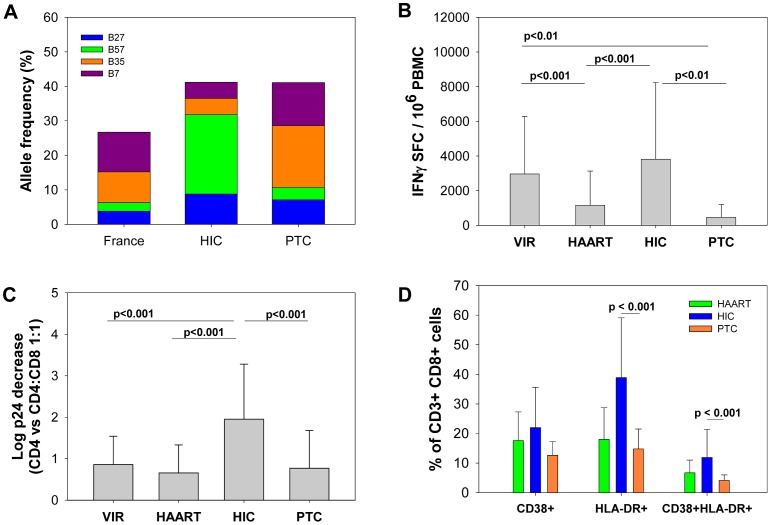
Post-treatment controllers differ from HIV controllers in terms of HLA class I profile, frequency and quality of the CD8+ T cell response and activation levels of CD8+ T cells.
A. The frequencies of the protective alleles HLA-B*27 and B*57 and the risk alleles HLA-B*07 and B*35 in the general French population (n = 6094 alleles [20], www.allelefrequencies.net), HICs (n = 148 alleles) and PTCs (n = 28 alleles). The statistical analyses are shown in Table S2. B. The frequency of HIV-specific CD8+ T cells, estimated as the number of CD8+ T cells producing IFN-γ upon stimulation with optimal HIV-1 peptides (spot-forming cells, SFC) in untreated viremic patients (VIRs) (n = 57), treated patients (ARTs) (n = 60), HICs (n = 100) and PTCs (n = 12). C. The capacity of CD8+ T cells from VIRs (n = 22), ARTs (n = 14), HICs (n = 73) and PTCs (n = 14) to suppress the HIV-1 infection of autologous CD4+ T cells, as determined by the log-fold decrease in the level of secreted p24 (CD4 vs. CD4∶CD8 1∶1 cell cultures). D. The percentage of CD8+ T cells from ARTs (n = 5), HICs (n = 58) and PTCs (n = 8) that expressed CD38, HLA-DR or both CD38 and HLA-DR ex vivo. B, C and D. The mean and standard deviation for each group are shown.